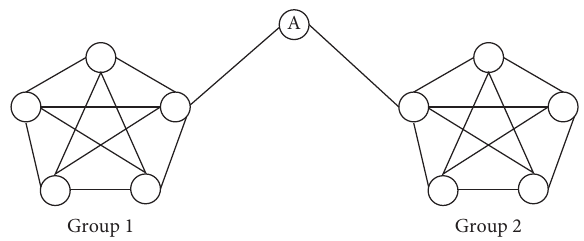
Figure 6: Schematic diagram of betweenness centrality of